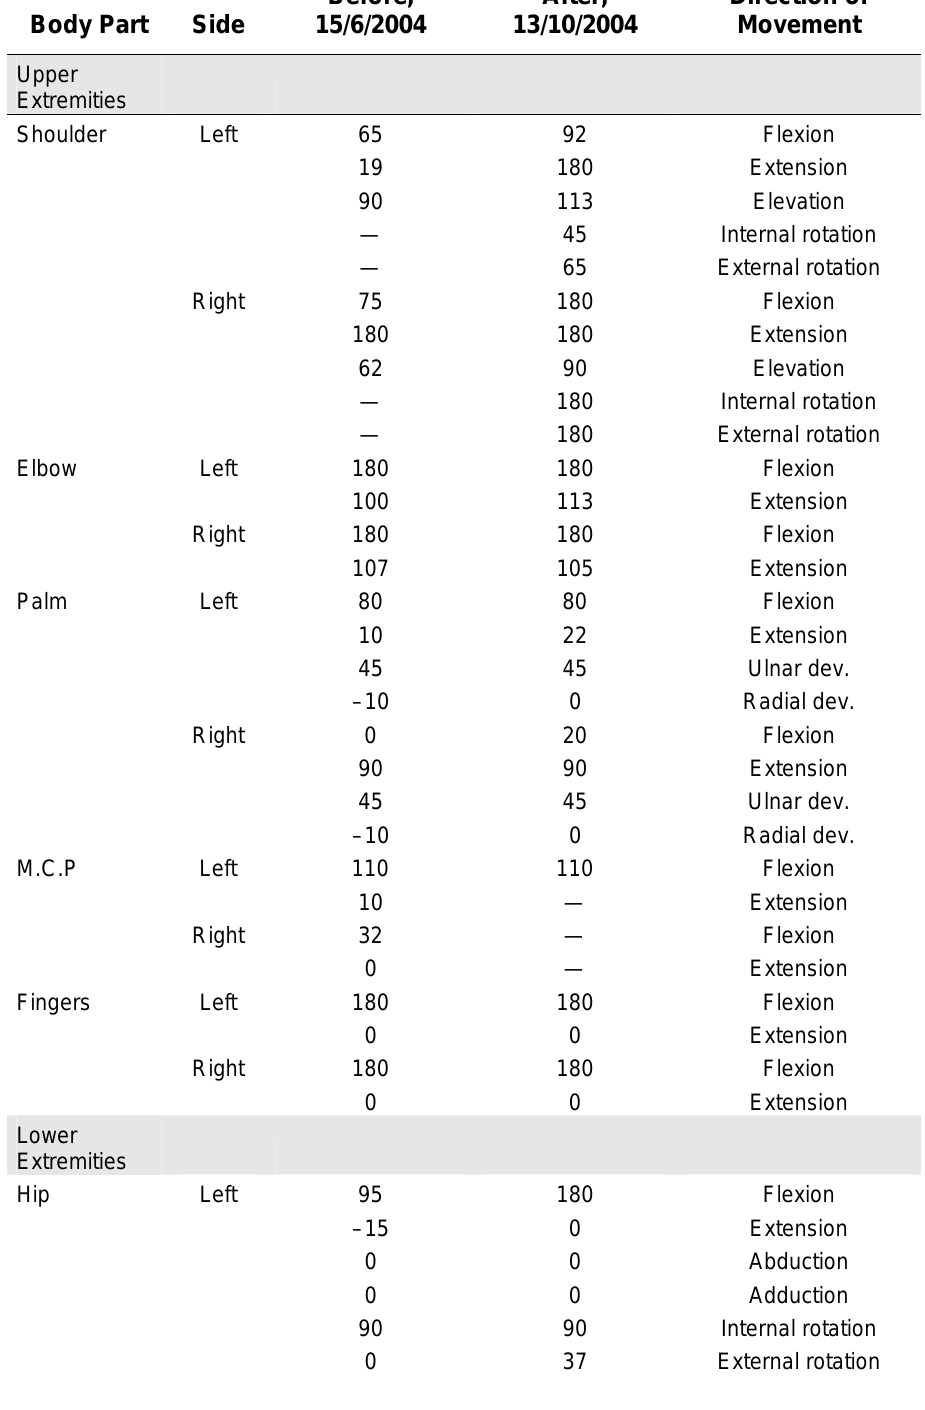
Difference in Range of Motion after a 4-Month Intervention Body Part